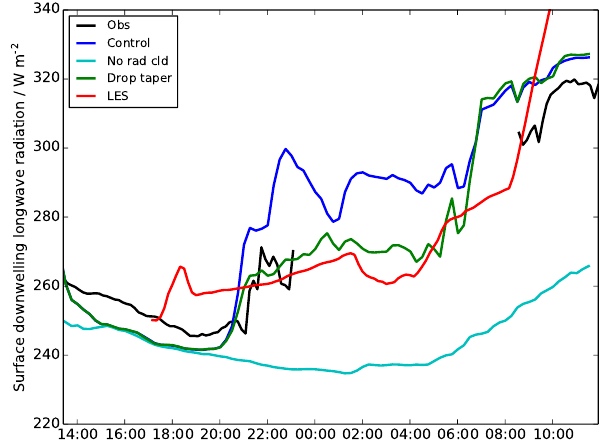
Figure 6. Time series of surface downwelling long-wave radia- tion, showing observations (black), LES (red) and UKV experi- ments: control (blue), radiatively inactive cloud (cyan) and modified droplet number (green).